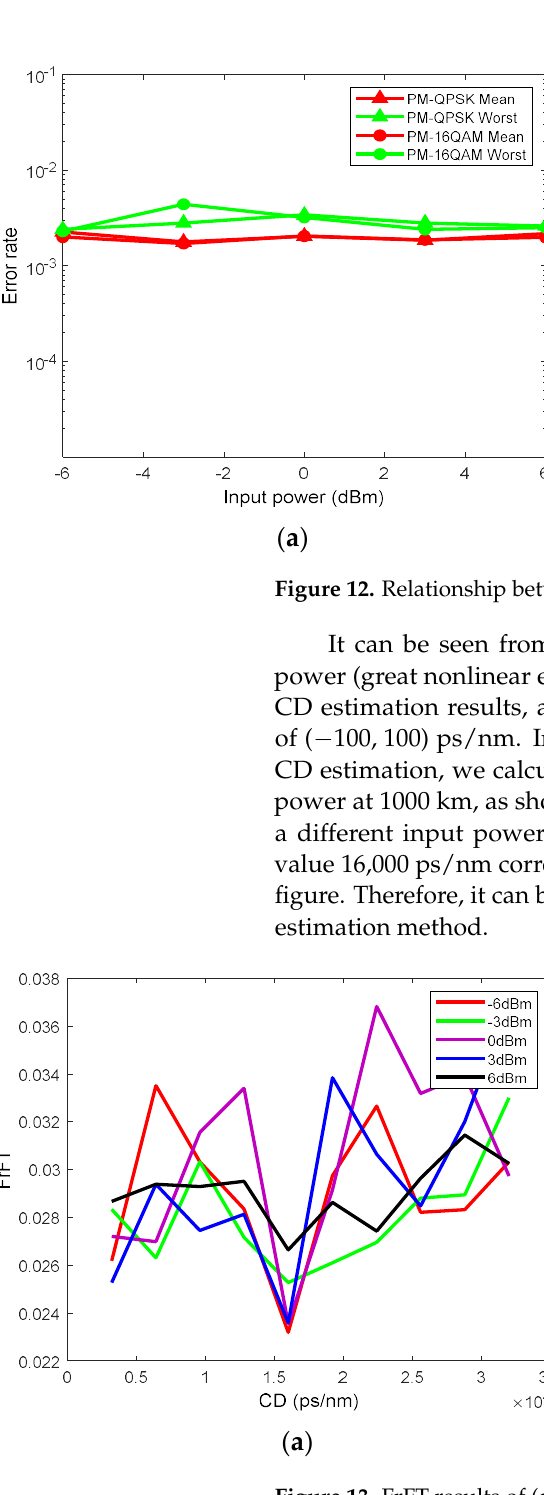
Figure 13. FrFT results of ( a ) PM-QPSK and ( b ) PM-16QAM signals under different input powers.